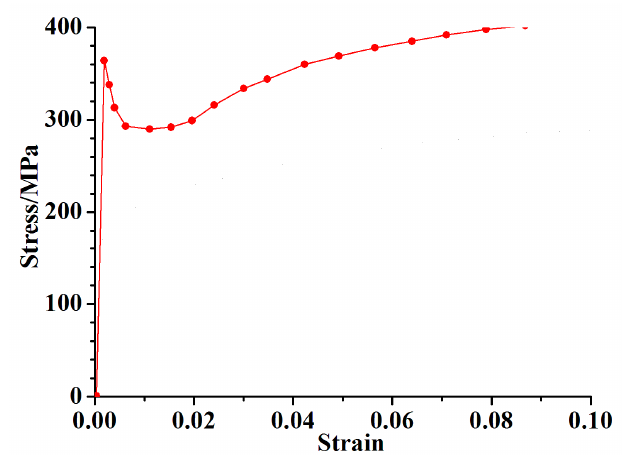
Figure 16. Engineering stress-strain curve of mild steel.